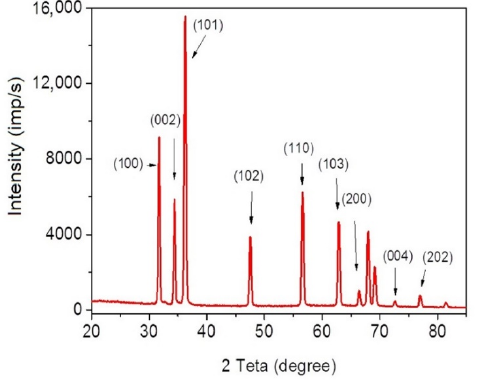
Figure 2. Diffraction pattern of ZnO nanoparticles. The PL spectra evolution (Figure 3) shows the significant growth in the peak intensity I pl of the UV PL band (387 nm) of the PNMC ZnO powder samples with a simultaneous narrowing of its half-width ∆ λ (from 19 to 14 nm, insert). This indicates the stimulated emission of the UV band contrary to the visible bands: 405 nm (C-V Zn ), 502 nm (V O ), 544 nm (O i ) [7] with weak increasing, and spontaneous emission. The large difference between the growth of the UV and visible bands (green and orange) with increasing excitation intensity indicates a low concentration of (O i , V O ) type defects, both a sign of a small excess and a deficiency of oxygen in the PNMC ZnO oxide powder. This is consistent with the conclusions from the Raman scattering spectra, Figure 1b, about the good crystalline quality of the PNMC ZnO powder, as well as with considerations in [24] regarding the excess or deficiency of oxygen anions in complex oxides of transition metals. The spectral position of the peak (405 nm) coincides with the position of the e–h plasma PL band at high excitation intensity I ex for the single crystalline ZnO film, obtained by MBE [4]. Nevertheless, the 405 nm peak for PNMC ZnO powder does not shift at all I ex levels. Besides, it is considerably narrower ( ∆ λ ≤ 2 nm) as compared to e-h plasma band ( ∆ λ ≈ 8 nm) shifted in case of the excitons decay and renormalization of the band gap. These circumstances indicate a high probability of the excitonic nature of the transmission in UV PL band (387 nm). Lasing at a wavelength of 387 nm occurs in the so-called diffusion mode due to the incoherent or “energy” FB [4]. In this case, adjacent modes spectrally overlap, which gives a continuous spectrum of emission. This result qualitatively differs from observations on the samples of the ZnO film with hexagonal microdisks formed by the method based on a low-temperature solution [20].